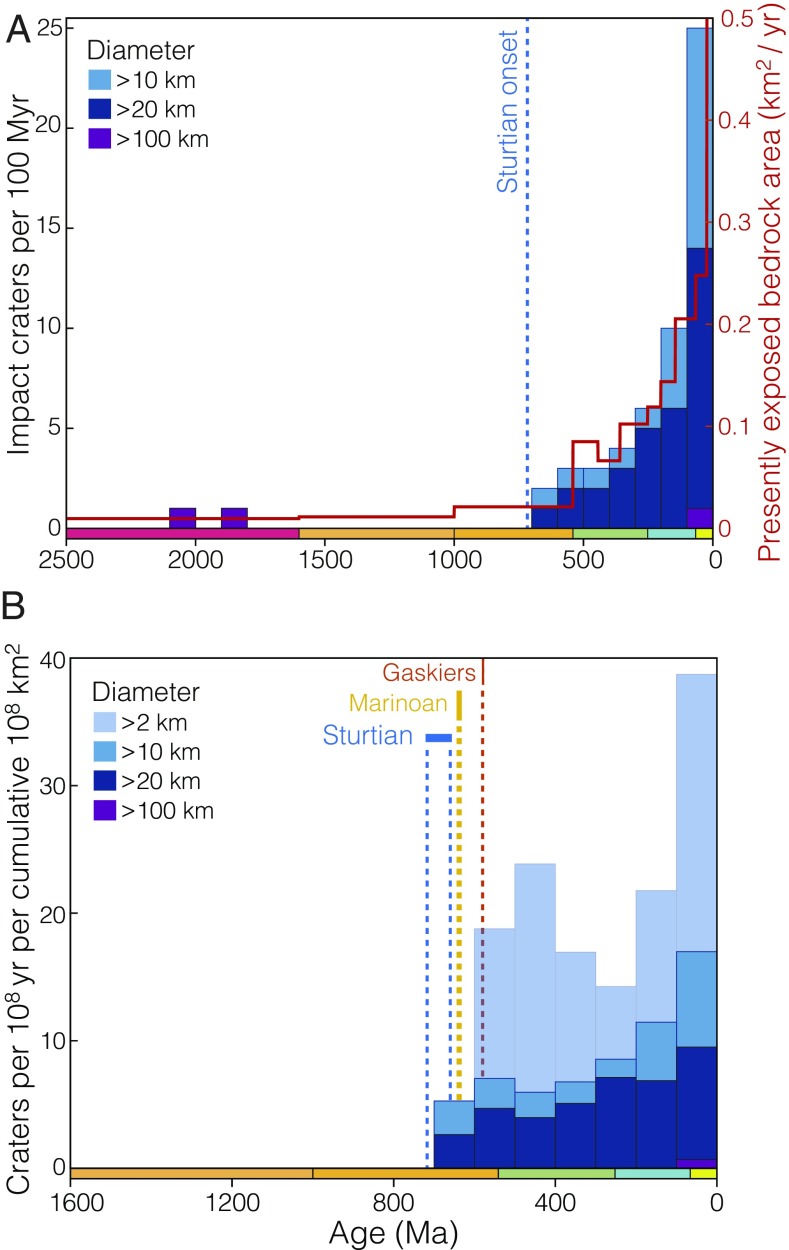
The record of impact craters preserved in Earth’s continental crust with formation ages known to within ±75 My (1-σ) from the PASSC database (42). (A) Absolute crater counts (left axis) for several size ranges tallied in 100-My bins over the past 2.5 Ga, plotted alongside global exposed bedrock area in km2/y (right axis) (43). (B) Apparent impact cratering rate per unit bedrock area area tallied in 100-My bins for crater diameters from 2 km to >100 km.